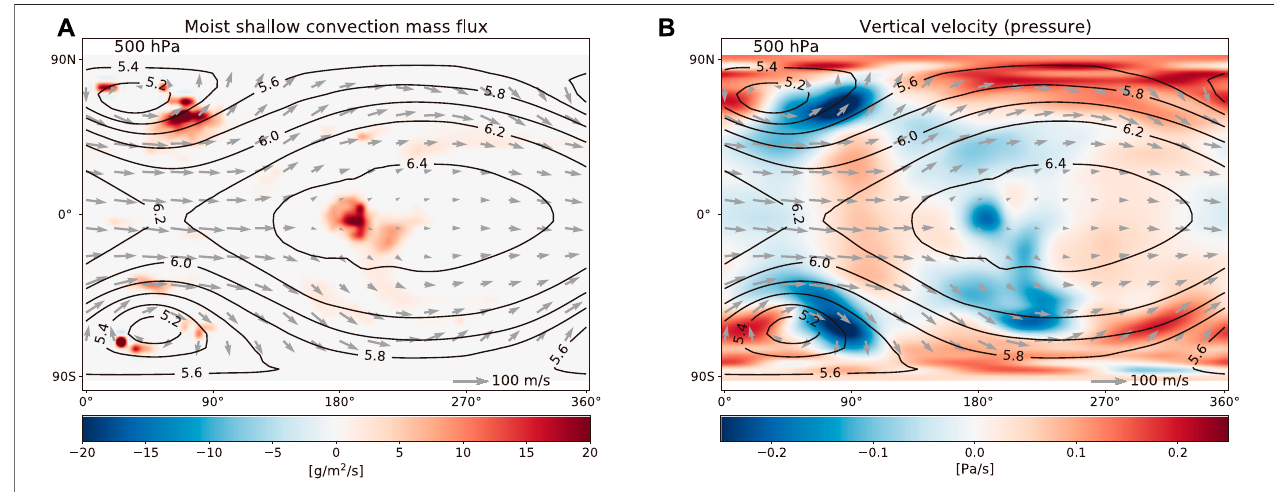
FIGURE 5 | Moist shallow convection mass fl ux [gm − 2 s − 1 , color shading in (A) ], horizontal winds at 500 hPa [ms − 1 , vectors in both (A) and (B) ], and vertical velocity at 500 hPa [Pas − 1 , color shading in (B) ] in the rapidly rotating case of six Earth days. Red color in (B) stands for descending motion and blue color in (B) stands for upward motion. Note that besides the strong convection at the substellar region, there is also shallow convection at the two cyclones near the morning terminator (90 °